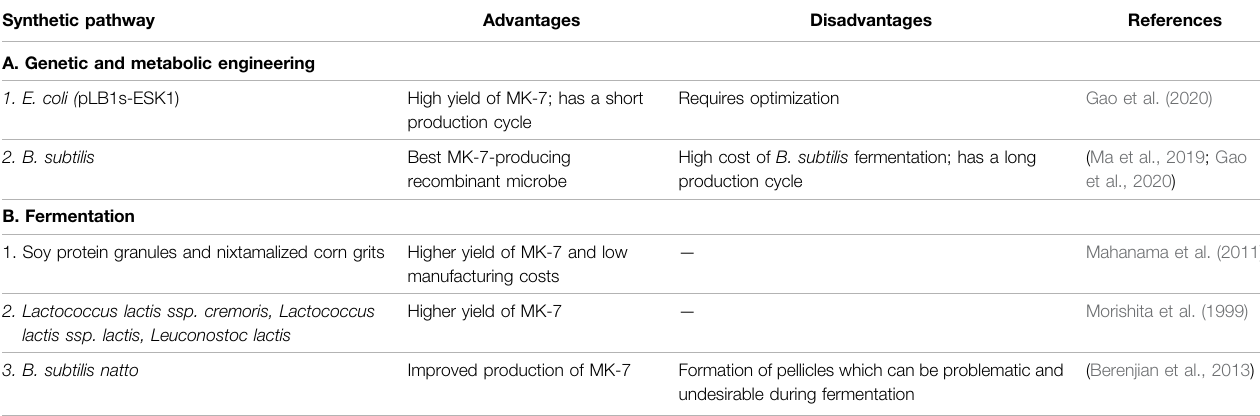
TABLE 1 | Synthetic pathways in production of vitamin K2-7.